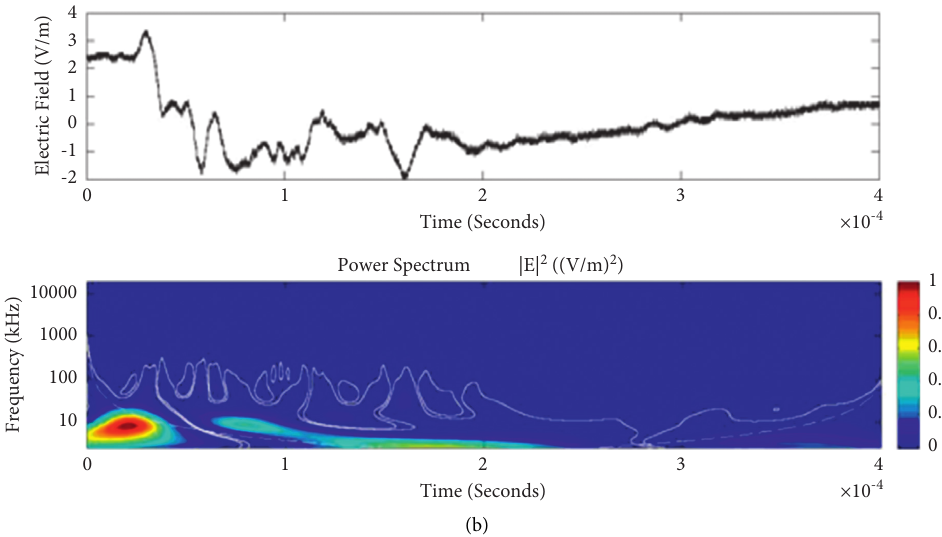
Figure 14: Example of the wavelet power spectrum of the first event (a) and second event (b) of the unusual lightning signal which is recorded as a flash number 20150610-0001 in Kathmandu, Nepal. The window size of the event is 400 μ s.